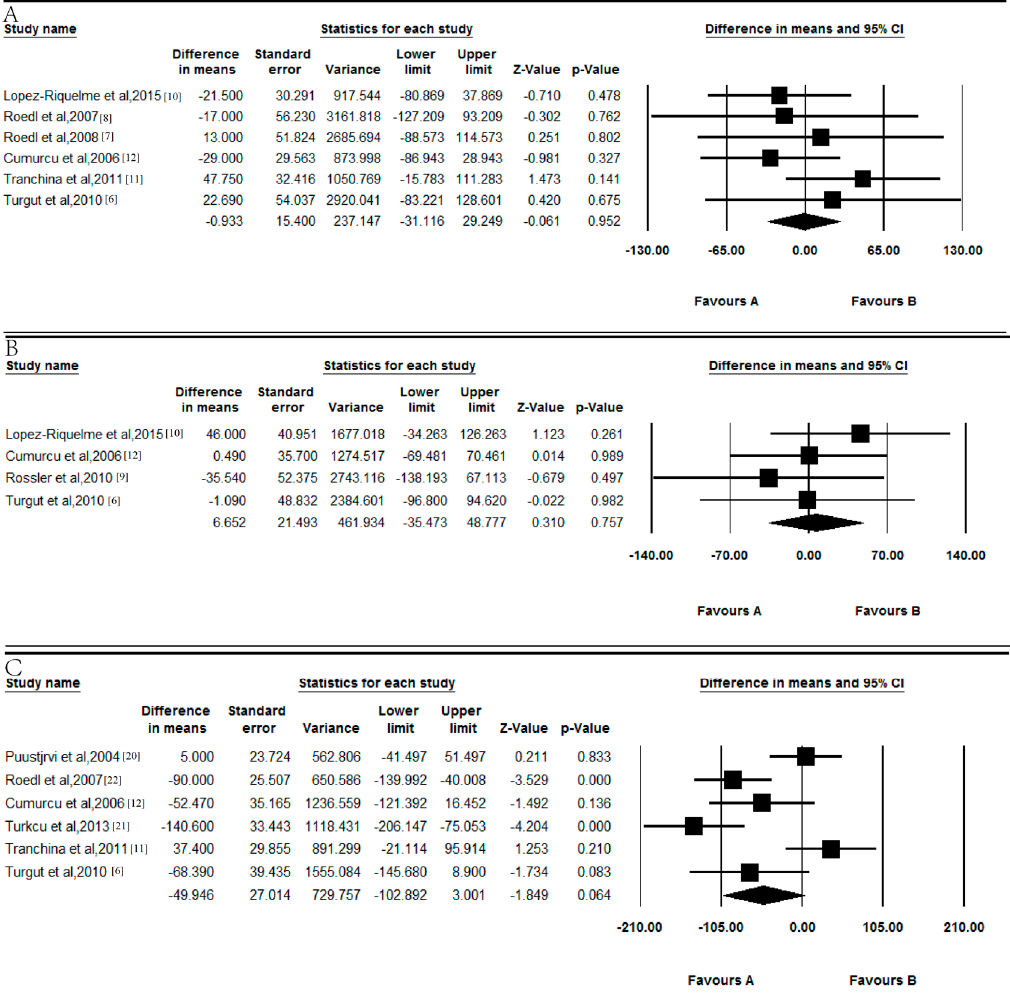
Figure 3. Forest plot of random effects meta-analysis showing the association of serum vitamin B 12 levels with POAG ( A ), NTG ( B ), and EXG ( C ).